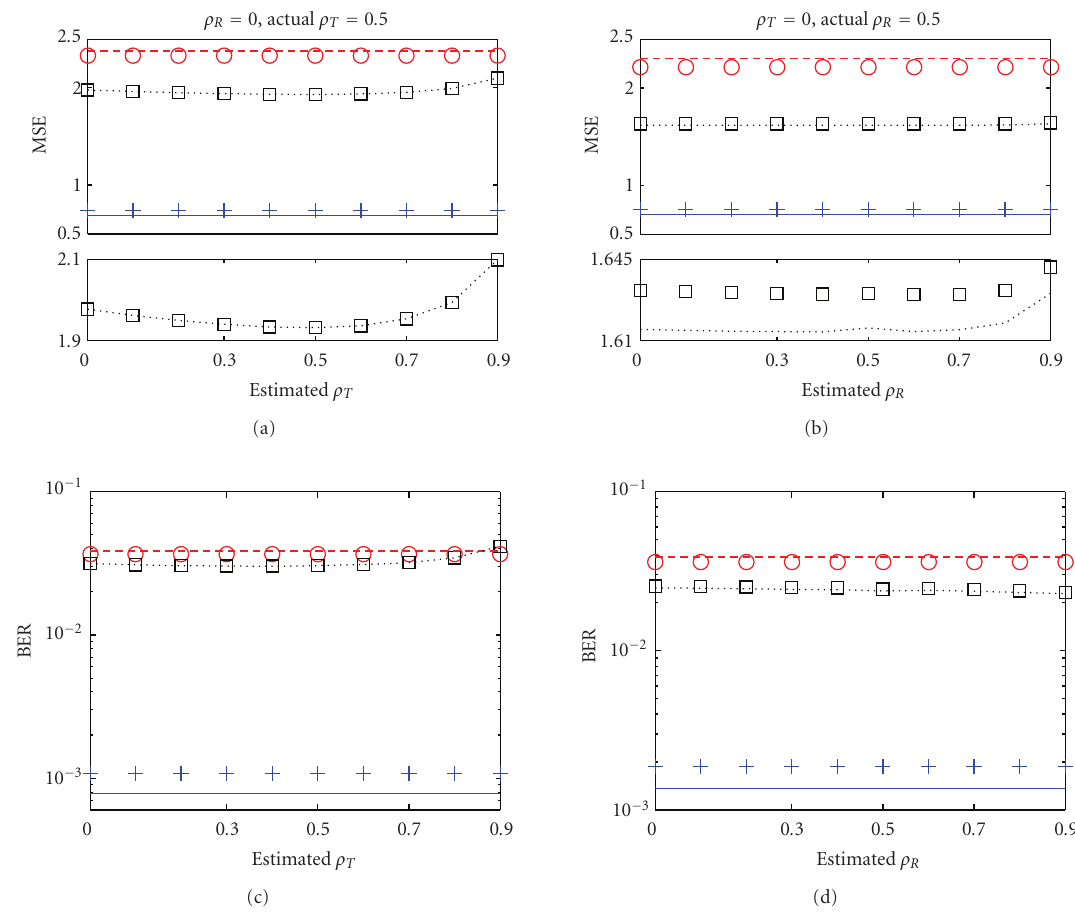
Figure 9: MSE and BER as functions of estimated ρ T or ρ R under per-antenna and per-cell power constraints (10log averaging over 20 channel realizations). ( Legends are the same as in Figure 5.